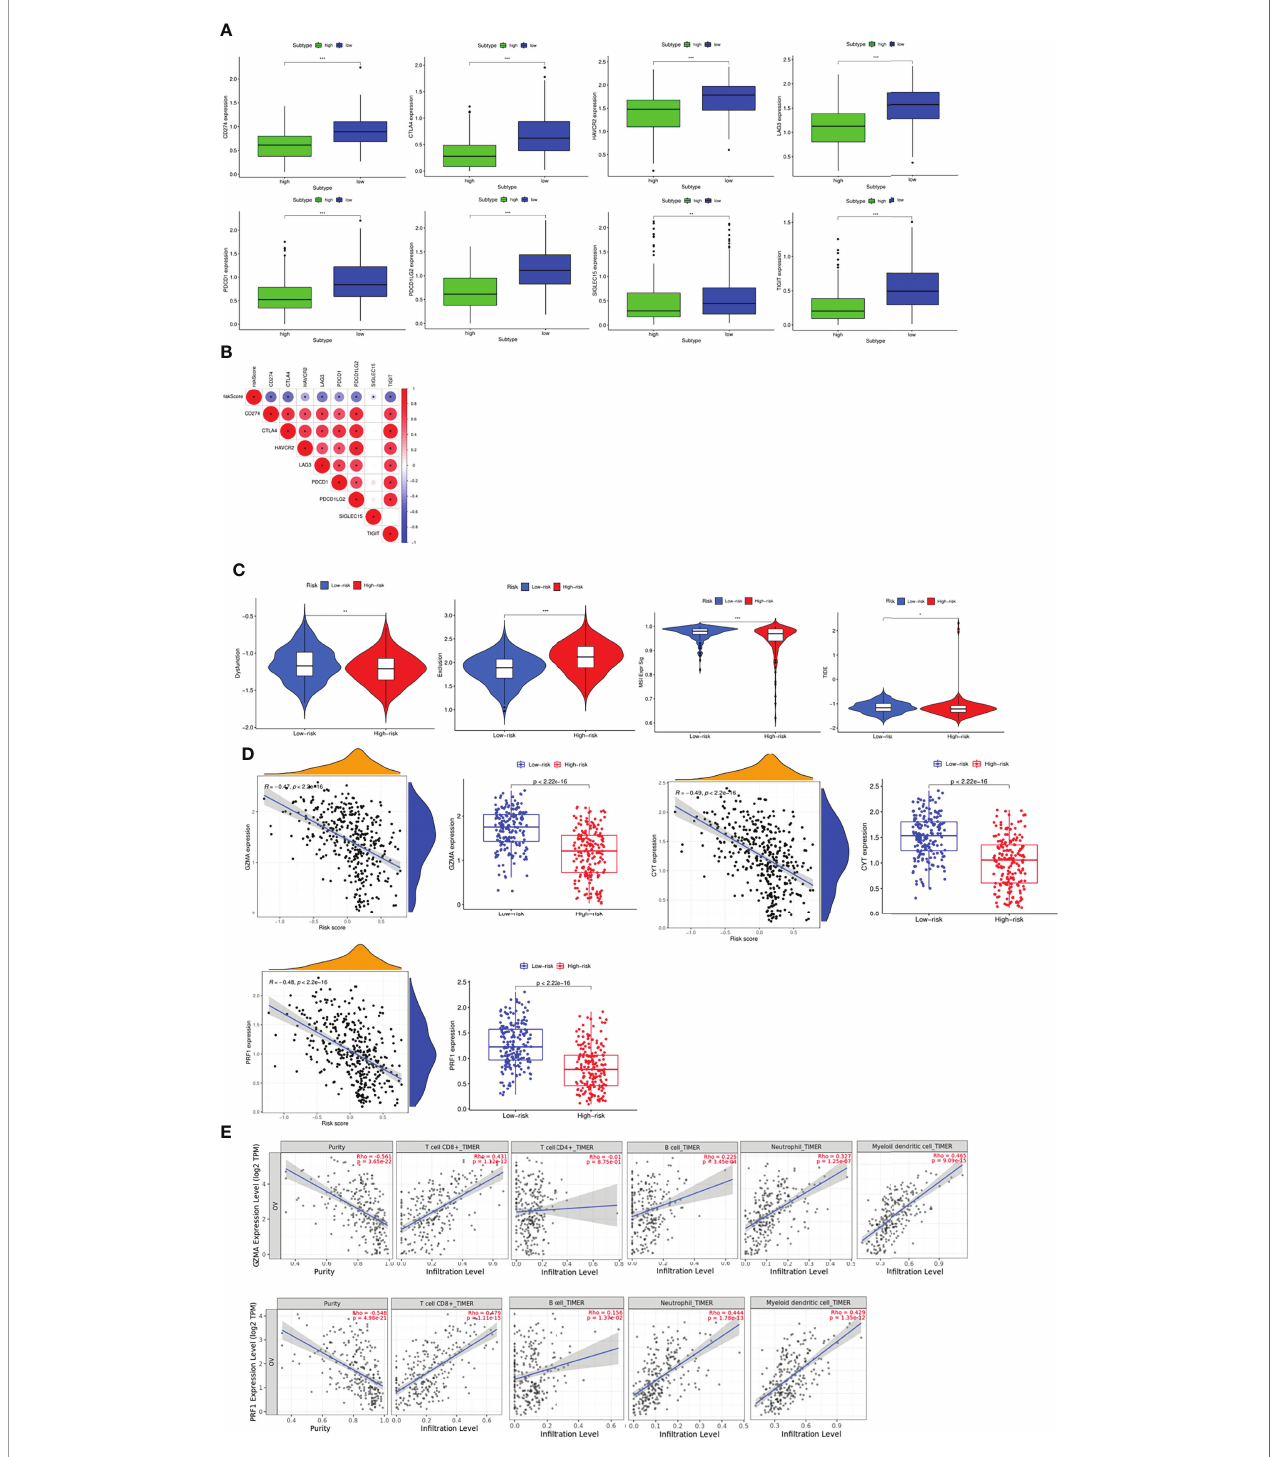
FIGURE 8 | Evaluation of the sensitivity to immunotherapy (A) Expression pro fi les of immune checkpoint molecules between groups. (B) Correlation between risk score and immune checkpoint molecules. (C) Evaluation of the sensitivity to immunotherapy via TIDE score. (D) Evaluation of the immunogenicity and the favorable immune TME of patients via CYT score. (E) Pearson analyses between the expression of GZMA, PRF1 and tumor purity, immune cells via TIMER. * P < 0.05, ** P < 0.01 and *** P <